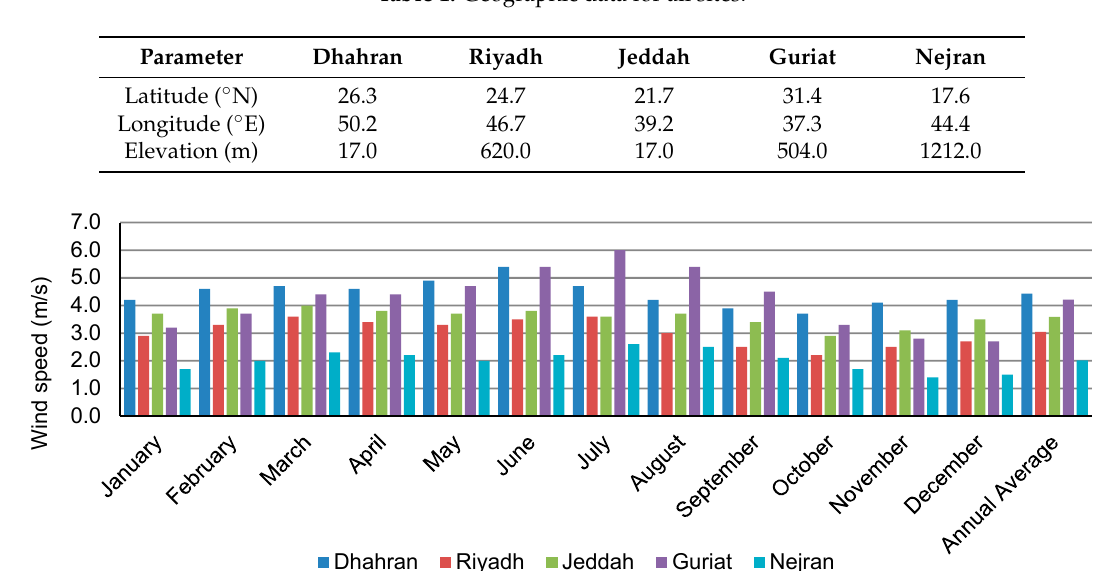
Figure 9. Monthly wind speed for all sites ( source: NASA ).